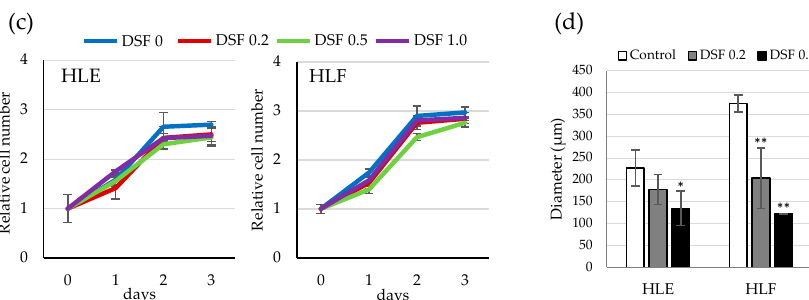
Figure 5. Involvement of aldehyde dehydrogenase (ALDH) activity in the sphere formation capacity of HDAC9-expressing undi ff erentiated HCC cells ( a ) Quantitative PCR of stemness-related genes Oct4, Bmi1, ALDH1A1, and ALDH1A3 in HLE ( left ) and HLF ( right ) cells treated with si-Control and si-HDAC9. The graphs are expressed as the relative expression to those of the si-Control group. UD; undetectable, ** p < 0.01 vs. si-Control. ( b ) Quantitative PCR of stemness-related genes in HLE ( left ) and HLF ( right ) cells treated with DMSO and BRD4354 (5 and 10 µ M). Quantitative PCR analysis was performed at n = 4. * p < 0.05, ** p < 0.01 vs. DMSO group. ( c ) Cell proliferation assays of HLE ( left ) and HLF ( right ) cells treated with 0, 0.2, 0.5, and 1.0 µ M of disulfiram (DSF) for 3 days. Cell viability was determined by WST assay and expressed as the relative amount of viable cells compared to day 0. ( d ) Spheres assay of HLE and HLF cells treated with 0, 0.2, and 0.5 µ M of DSF for 7 days. The diameter of the sphere was measured in five representative spheres of each group. * p < 0.05, ** p < 0.01 vs. vehicle control.